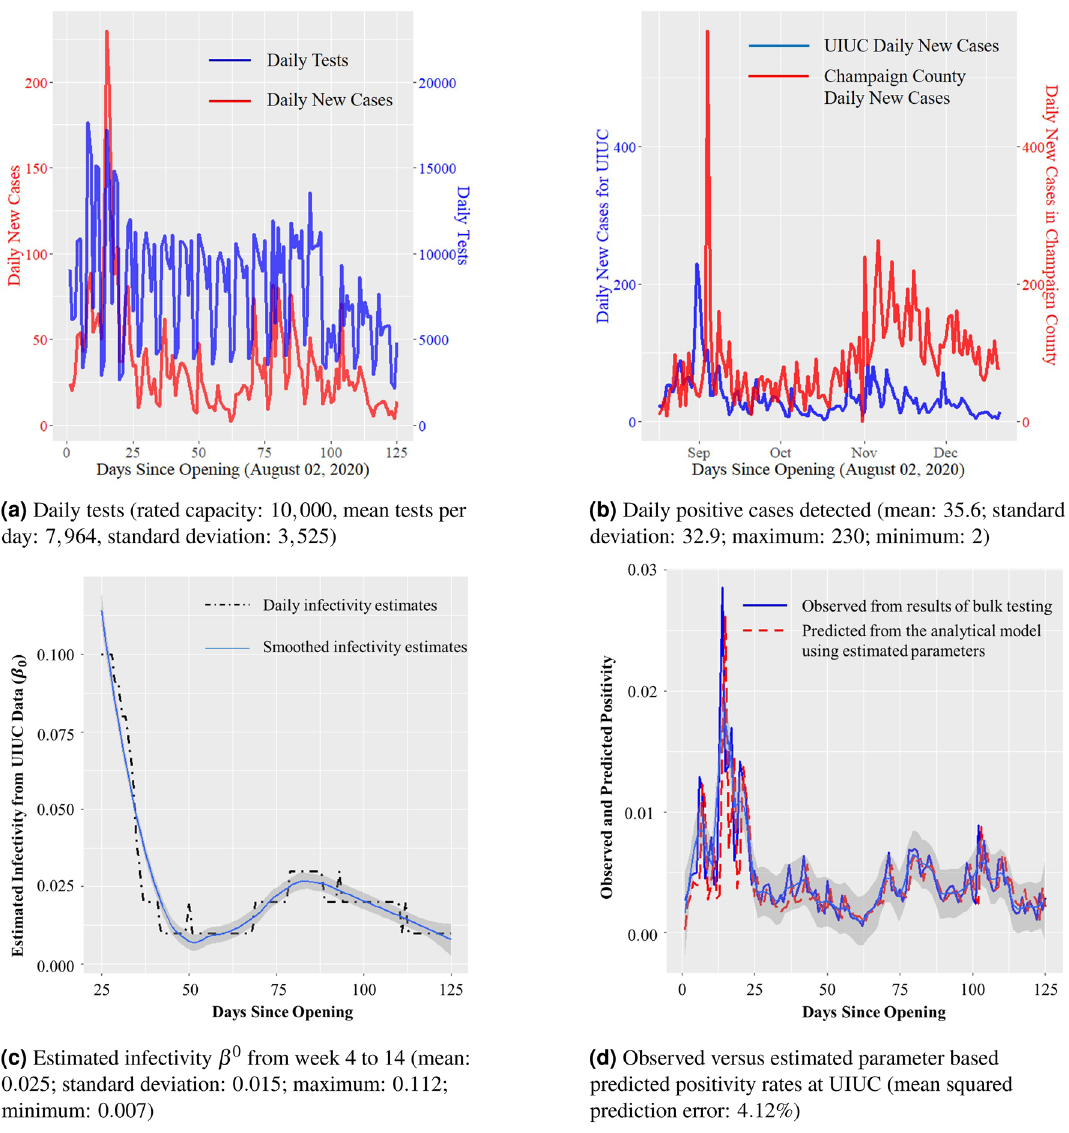
Figure 2. Visualization of the data and the results of parameter estimation from the UIUC SHIELD